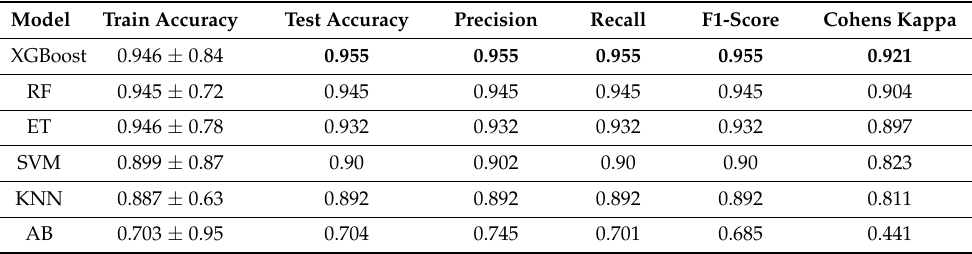
Table 5. Machine-learning model performances on training and test sets for three-class classification using all the features. The best performances are highlighted in bold.